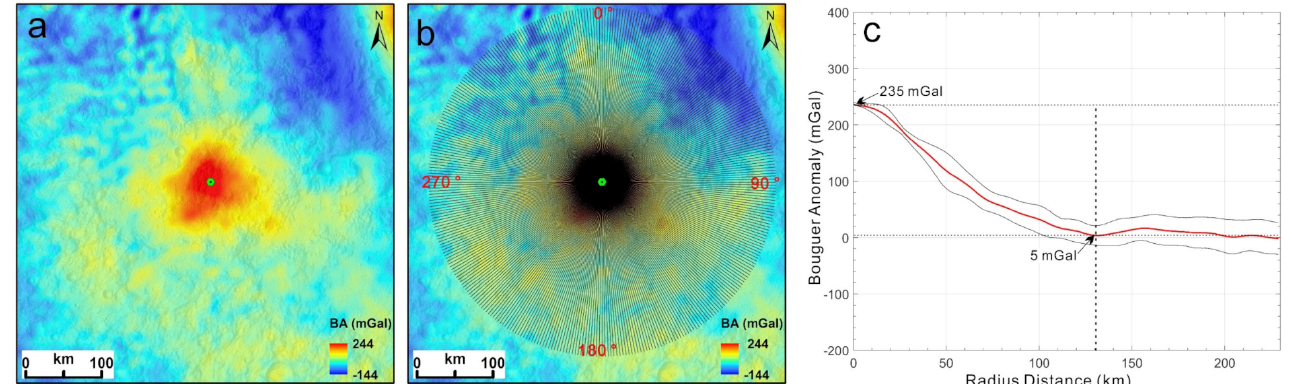
Figure 2. ( a ) Bouguer anomaly map of the Orientale basin’s southwestern region; ( b ) the azimuth radial profiles of elevation by 1 ◦ bearing from the north (clockwise, total 360 lines); ( c ) the average radial profile (red curve) of Bouguer anomaly and uncertainties (one standard deviation, between the two black curves). The distance between maximum central gravity anomaly and minimum gravity anomaly value ( R BA ) is ~130 km. (Orthographic Projection centered at 108.8 ◦ W, 28.4 ◦